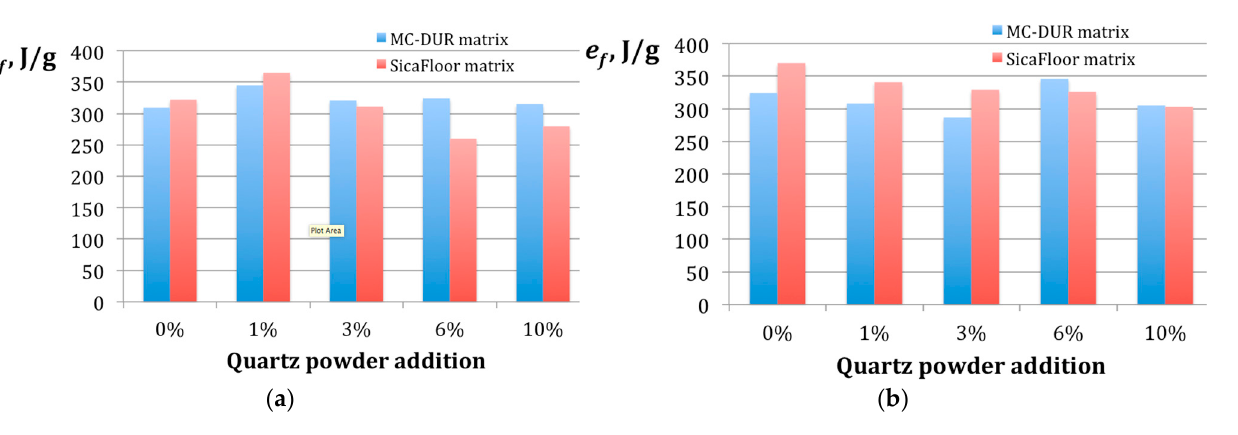
Figure 6. Some examples of the worn composite surfaces with the polymer matrices Sikafloor 156 with the particulate filler proportions of 10 wt.%: ( a ) with the emulsion binder; ( b ) with the powder binder.